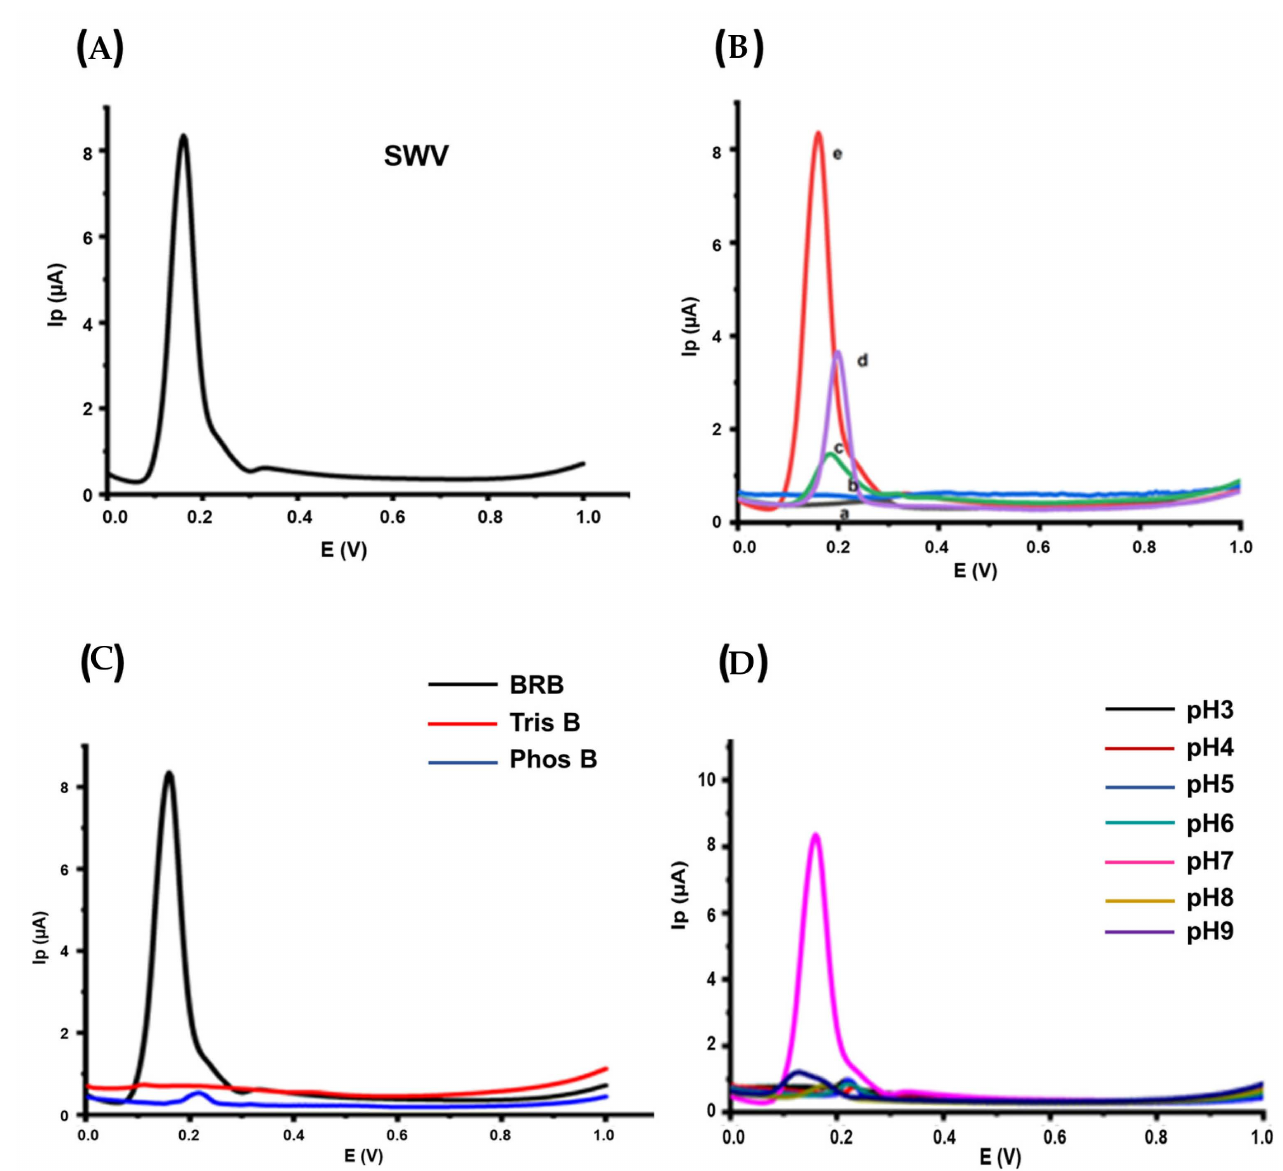
Figure 9. ( A ) SWV of 0.02 µ M Hg 2+ at XG-AgNPs/Nafion-modified GCE; ( B ) SW voltammograms for 0.02 µ M Hg 2+ at (a) bare GCE, (b) GCE/Nafion, (c) GCE/Xanthan gum, (d) GCE/XG-AgNPs, (e) GCE/XG-AgNPs/Nafion; ( C ) Effect of different supporting electrolytes each of pH 7 (a) 0.04 M BRB, (b) 0.1 M Tris buffer and (c) 0.1 M phosphate buffer in the presence of Hg +2 ; ( D ) Effect of pH on peak current and shift in peak